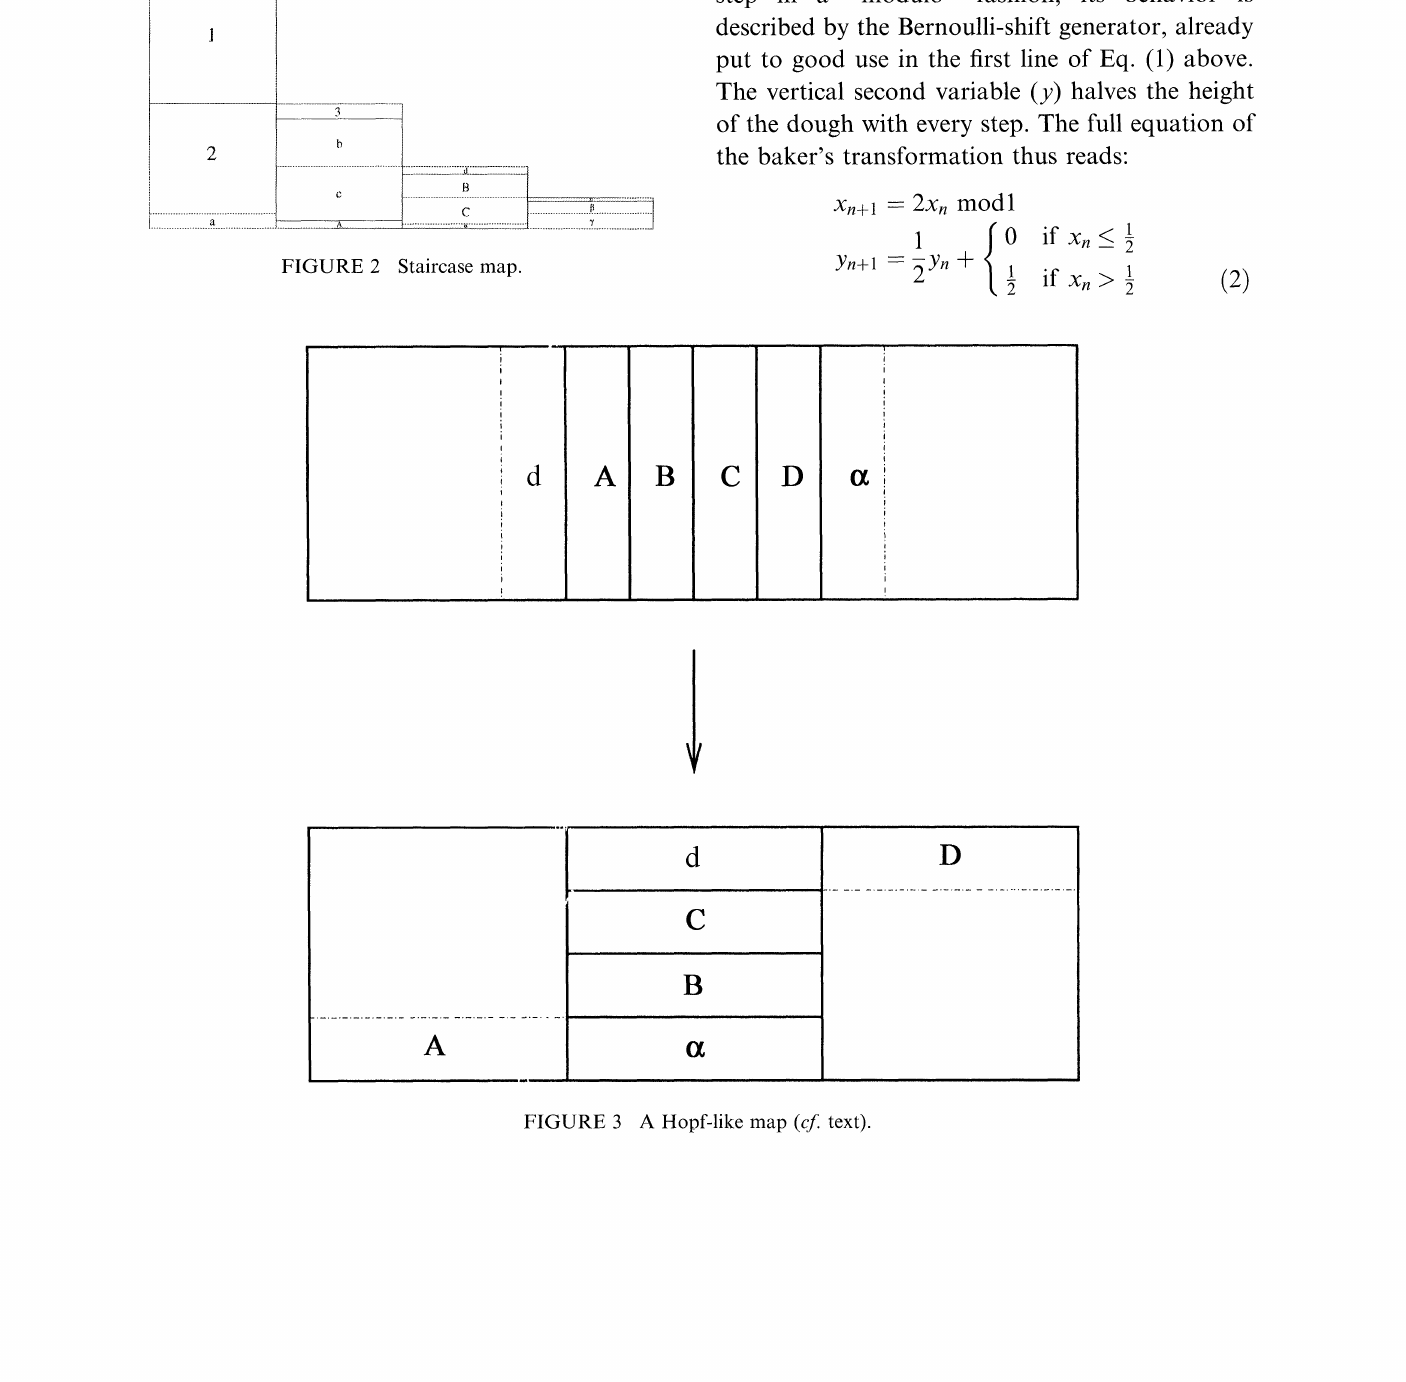
FIGURE 2 Staircase map.